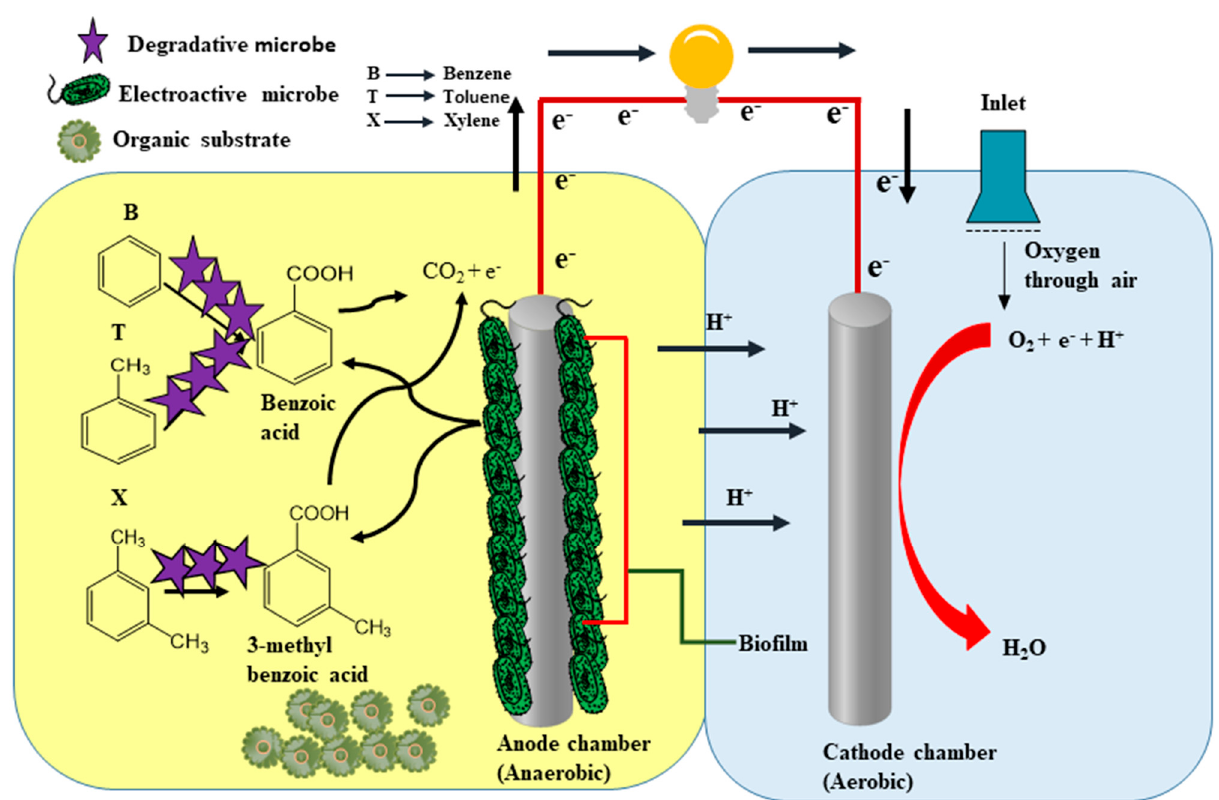
Figure 3. Schematic illustration of general mechanism of benzene, toluene and xylene (BTX) by BMFCs. The bioactivity degradative microbes are pollutants degrading microbes which produced the pollutant intermediates, while electroactive microbes attach to the anode and form biofilm. This biofilm attacks the intermediate to generate CO 2 and